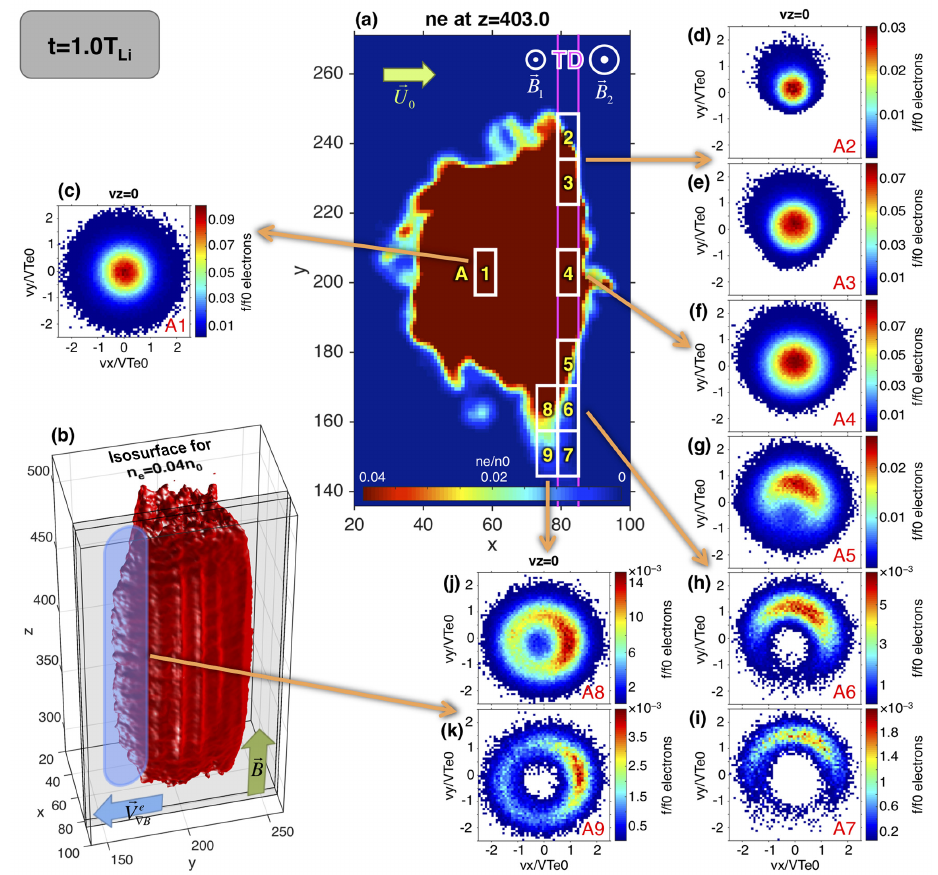
Figure 2. Snapshot of 3-D PIC simulation at t = 1 T Li (phase A). (a) Electron number density in the xOy plane for z = 403. (b) The 3-D density isosurface for n e = 0 . 04 n 0 . (c–k) Electron VDFs in the space of perpendicular velocities for the spatial bins shown with white rectangles in panel (a) . The two magenta lines mark the TD’s